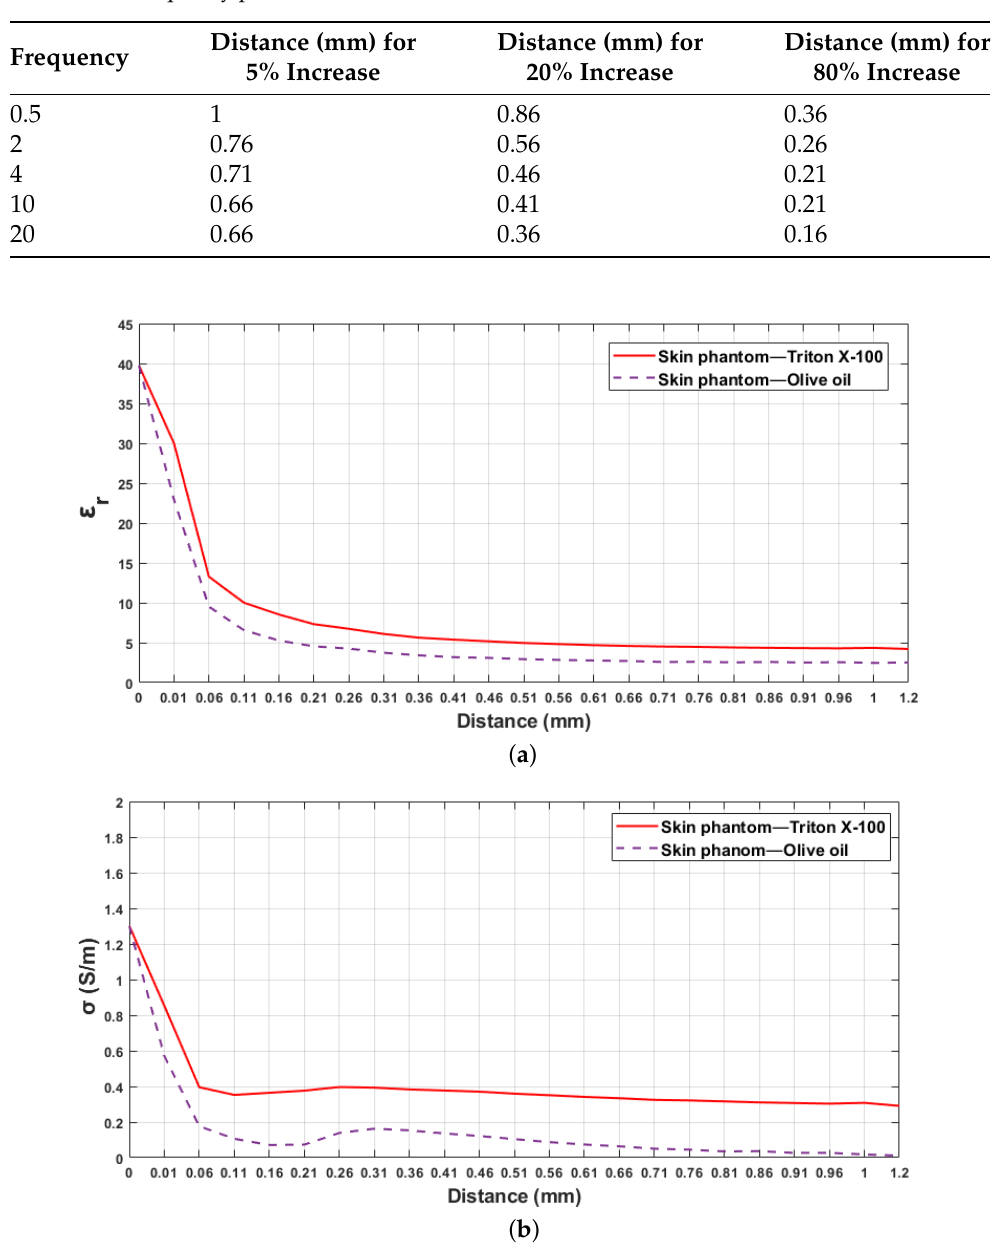
Figure 10. Skin–triton X-100 and skin–olive oil simulated dielectric properties: ( a ) relative permit- tivity, ( b ) conductivity as a function of probe’s distance from first layer at 4 GHz